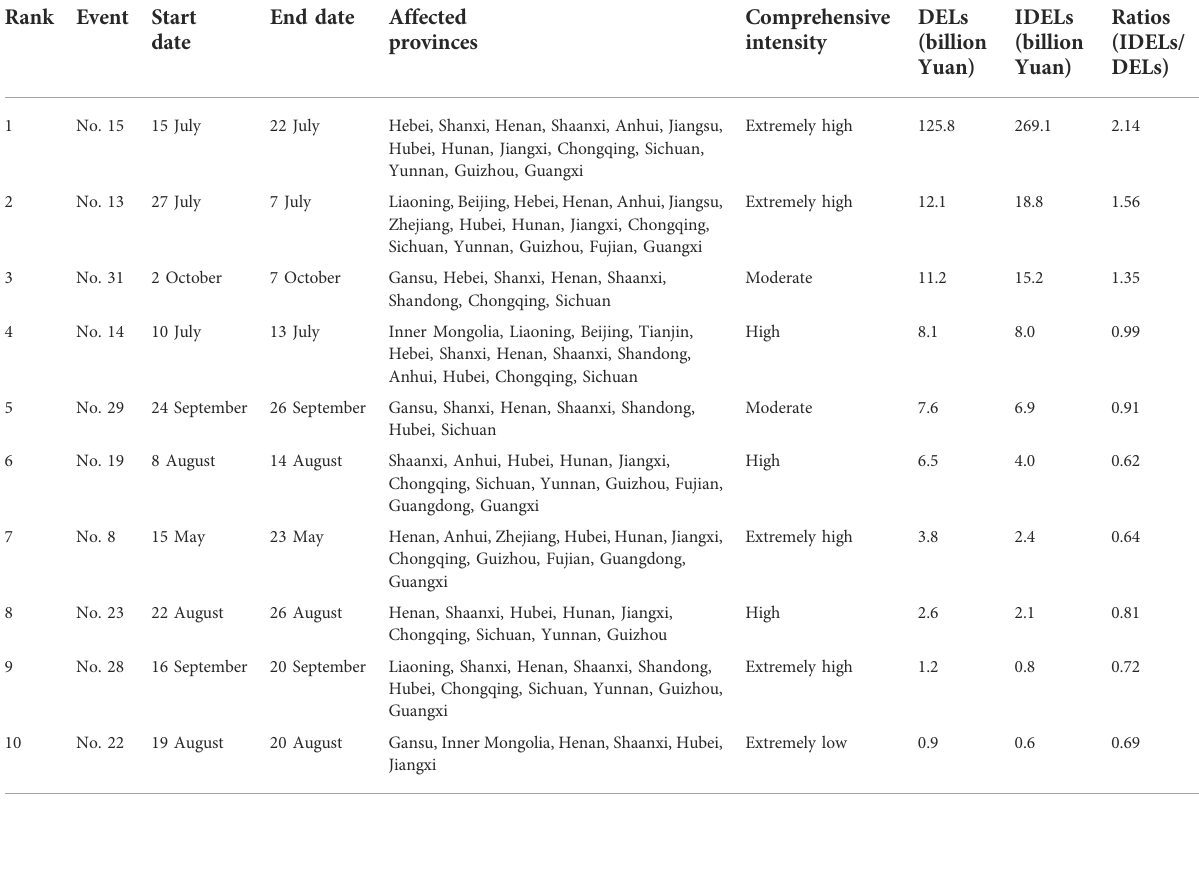
TABLE 1 The top ten rainstorm events for DELs in 2021.